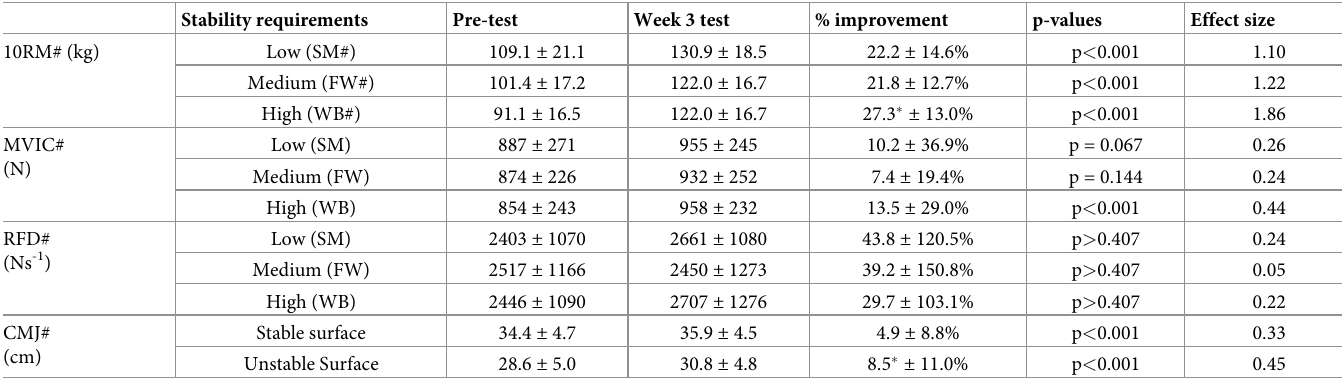
Table 2. Changes in 10RM, MVIC, RFD and CMJ for the different stability requirements between pre- and week 3 test. Stability